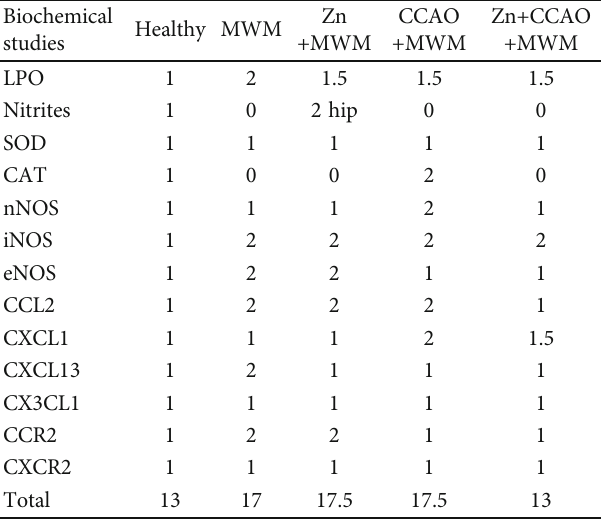
Table 5: Hierarchization score of the protective e ff ect of pharmacological strategies (HSPEPS) in biochemical studies.